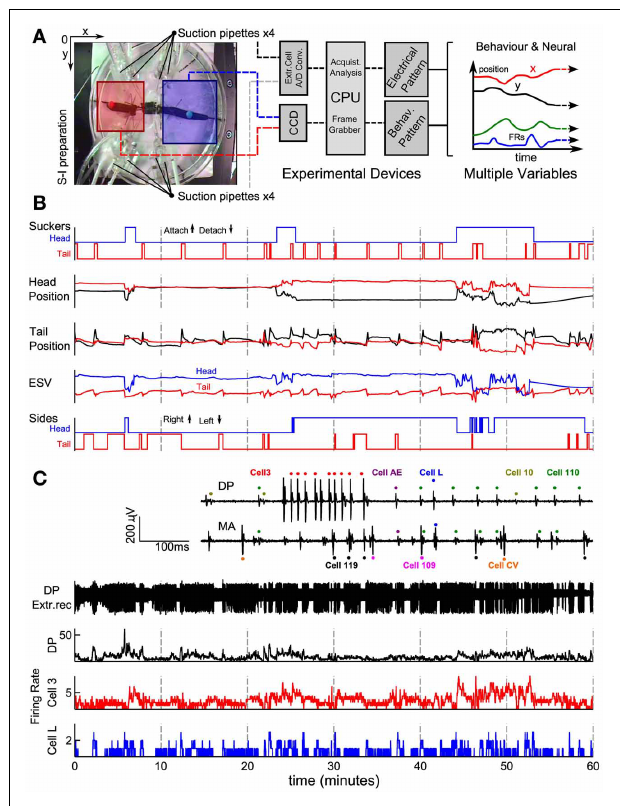
FIGURE 1 | Recording set-up and signal processing of behavioral and electrical data. (A) Experimental set up showing an image of a semi-intact preparation taken with the CCD camera. Squares represent regions where the head (blue) and the tail (red) were usually located. An algorithm was able to detect and track the beads attached. Four suction pipettes were positioned at the left and four at the right side of the leech able to provide eight simultaneous electrical recordings. In the middle and left part of the panel a scheme of the overall system. (B) Behavior’s characterization. Panel represents from top to bottom the time’s evolution of sucker states, original head and tail coordinate positions (Cartesian coordinates x and y represented with red and black traces, respectively), ESV (Elongation-Shortening-Vector) and sides (steps) indicating whether the head and tail of the leech was at the right or left, respectively. Up indicates that the bead was located on the right side and down indicates that the bead was on the left side. (C) Electrical recordings. Inset shows extracellular recordings from the DP and MA nerves showing APs from motoneuron L (blue dots), 110 (green dots), AE (purple dots), 3 (red dots), 10 (yellow dots), CV (orange dots), Cell 109 (magenta dots), and 119 (black dots). From top to bottom: an example of an electrical recording from a DP nerve obtained with a suction electrode; firing rates of all APs recorded from that DP nerve (black), from an identified motoneuron 3 (red middle trace) and identified L (blue trace). AFRs binwidth